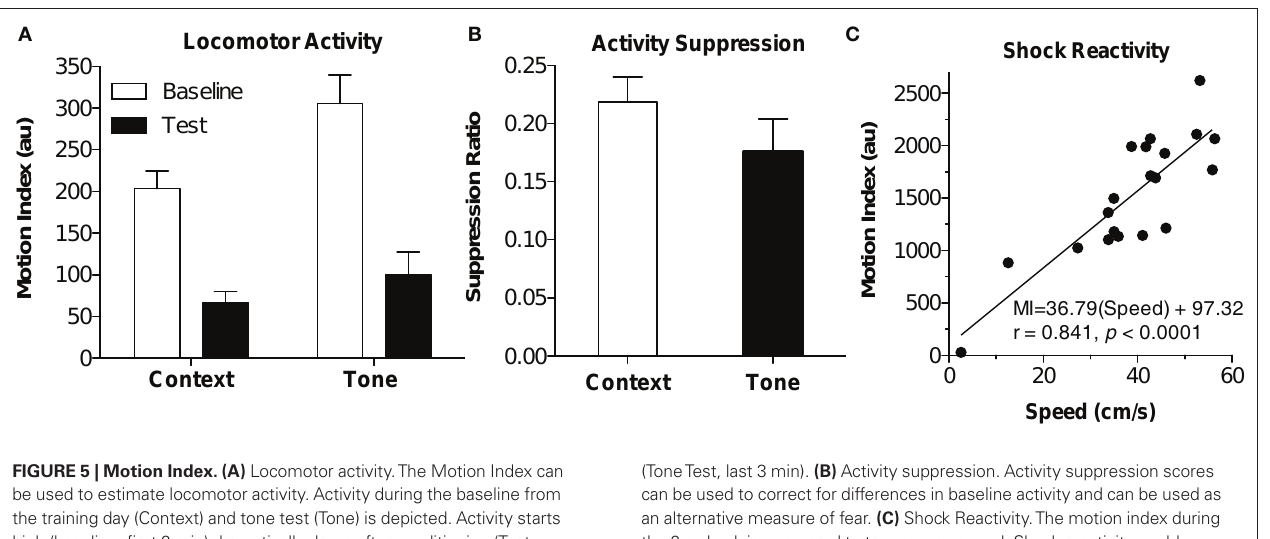
(Tone Test, last 3 min). (B) Activity suppression. Activity suppression scores can be used to correct for differences in baseline activity and can be used as an alternative measure of fear. (C) Shock Reactivity. The motion index during the 2-s shock is compared to true mouse speed. Shock reactivity could reliably be measured using the motion index and showed a good linear fit with true